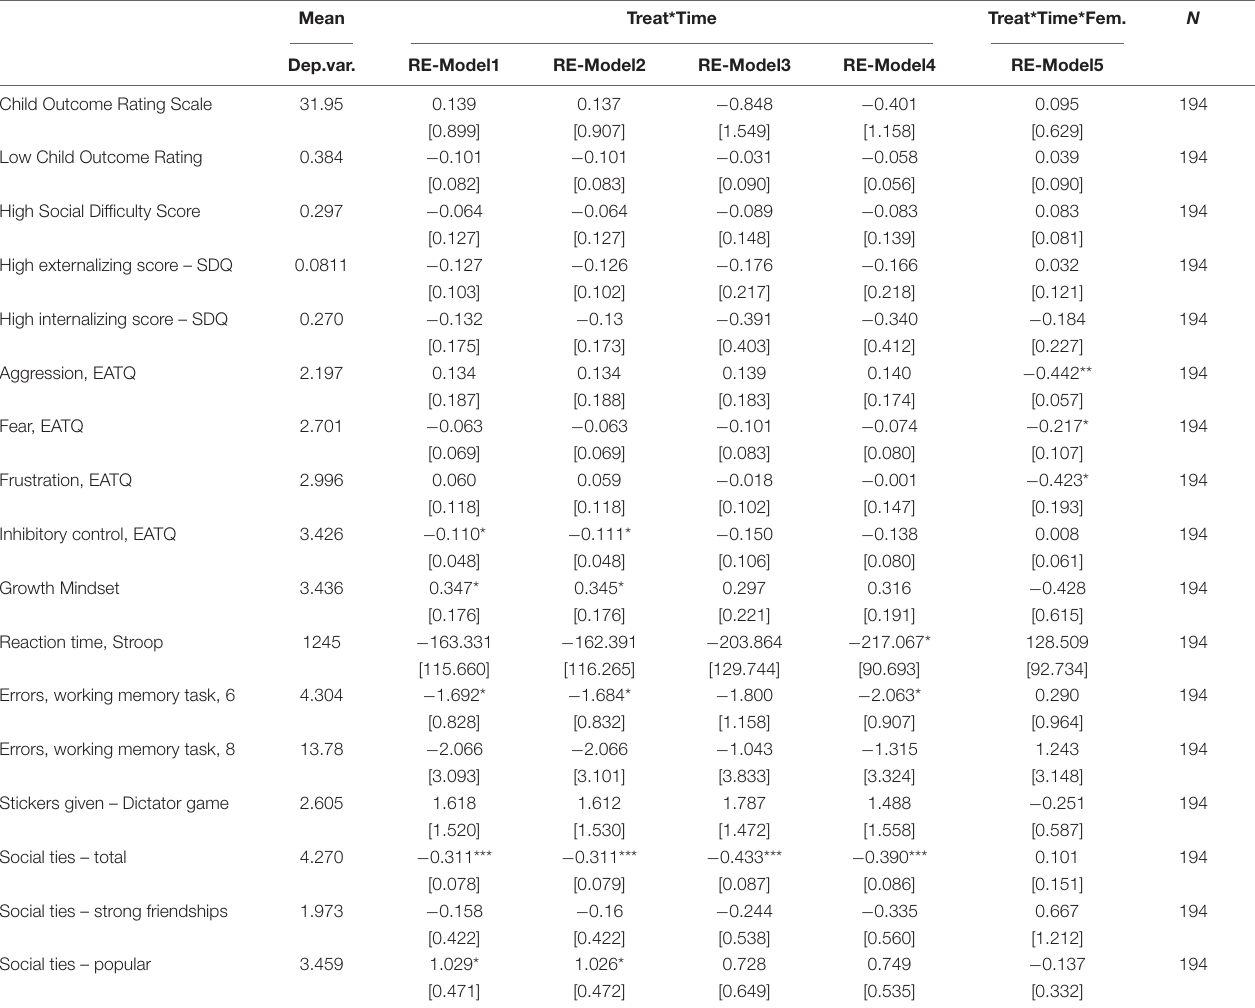
TABLE 6 | Random effects panel estimates – Treatment effects in the Irish setting. Mean Treat*Time Treat*Time*Fem. N